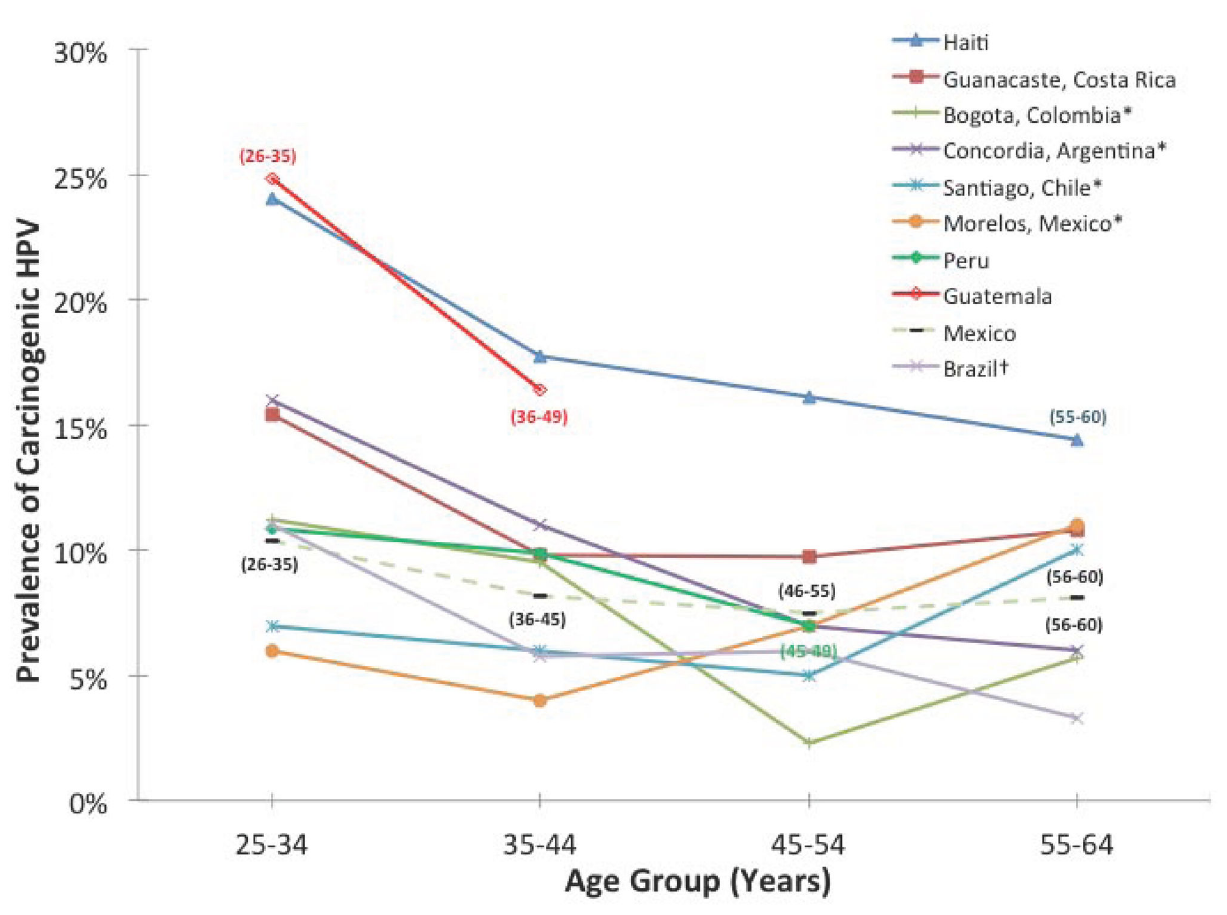
Figure 2. Age-range-specific carcinogenic HPV prevalence in Latin America compared to Haiti. carcinogenic HPV prevalence for selected cross-sectional studies conducted in Latin America: Haiti (from this study); Guanacaste [16]; Colombia [17], Argentina [18], Chile [17], Mexico [17]; Peru [18]; Guatemala [20]; and a second study from Mexico [19]. *estimated from graphs; †Drs. Eduardo Franco and Luisa Villa, unpublished data, Ludwig-McGill Cohort, Brazil. doi: